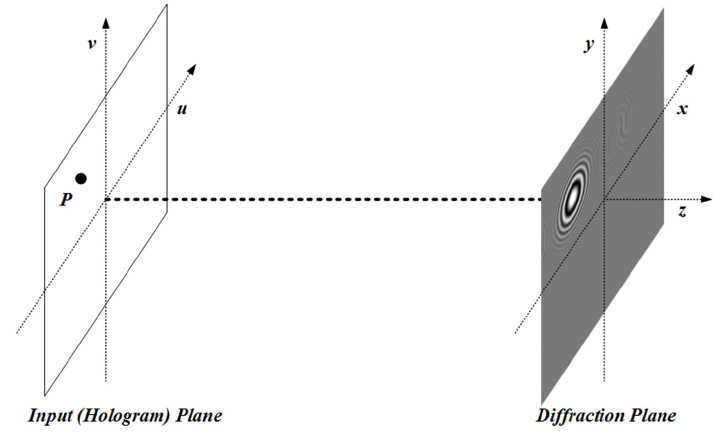
Figure 1. Diffraction between two planes.